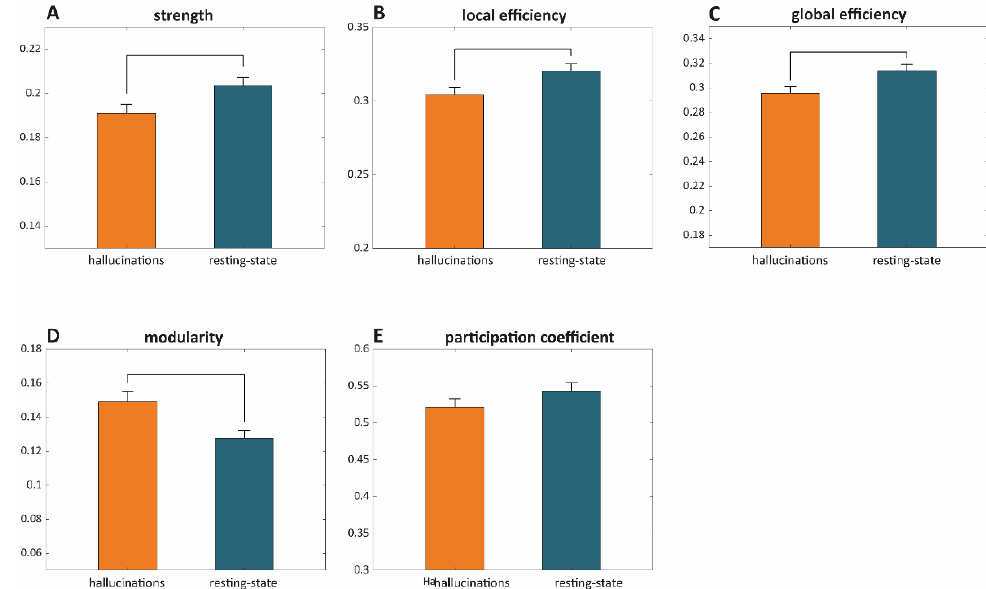
Figure 4. For each graph metric in the theta band, descriptive statistics for the two conditions are presented (mean + standard error). In each subplot, the orange bar represents the considered metric estimated during the VH condition, while the blue bar represents the metric related to the RS. Significant between-condition differences ( p < 0.05 after FDR correction) are highlighted by a black line connecting the two bars. Graph strength is presented in ( A ), local efficiency in ( B ), global efficiency in ( C ), modularity in ( D ) and participation coefficient in (E).